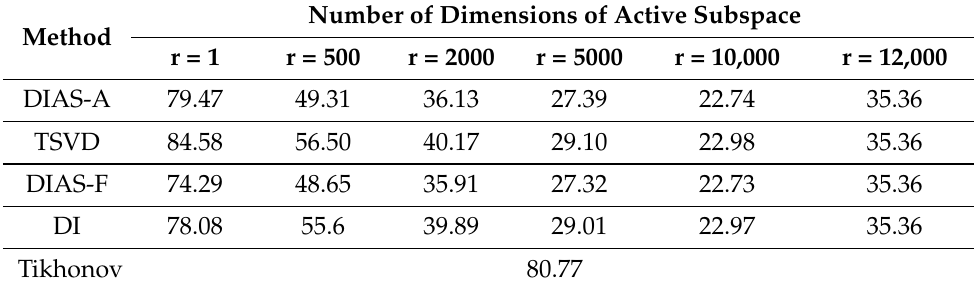
Table 5. Relative error (%) of inverse solutions by DIAS and Tikhonov regularization for overregular- ization case with α = 10 8 , noise level 1%.